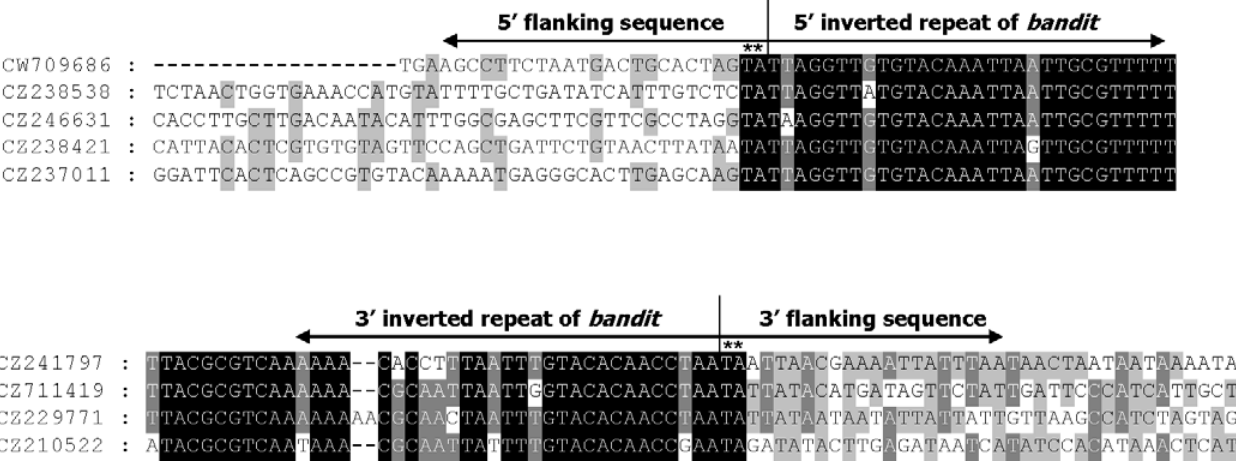
Figure 7. Multiple sequence alignment of the nucleotide sequences flanking the insertion sites of copies of the bandit transposons within the genome of Ancylostomacaninum. Alignments of nucleotide sequences flanking the 5 9 - (A) and 3 9 - (B) termini of bandit . Conservation of residues is indicated by the shading of boxes. Target sequences, with GenBank accession numbers as indicated on the left, were identified among entries in the GSS database of A. caninum sequences at GenBank. The target site TA duplications are indicated with asterisks.